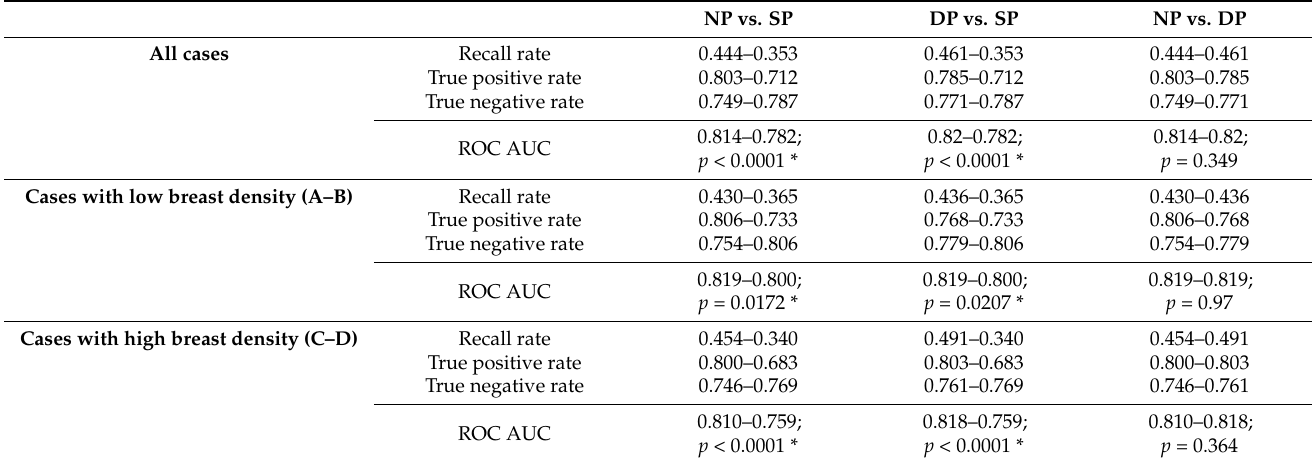
Table 3. Diagnostic performances of radiologists among cases without prior, and with prior images from same vendor and different